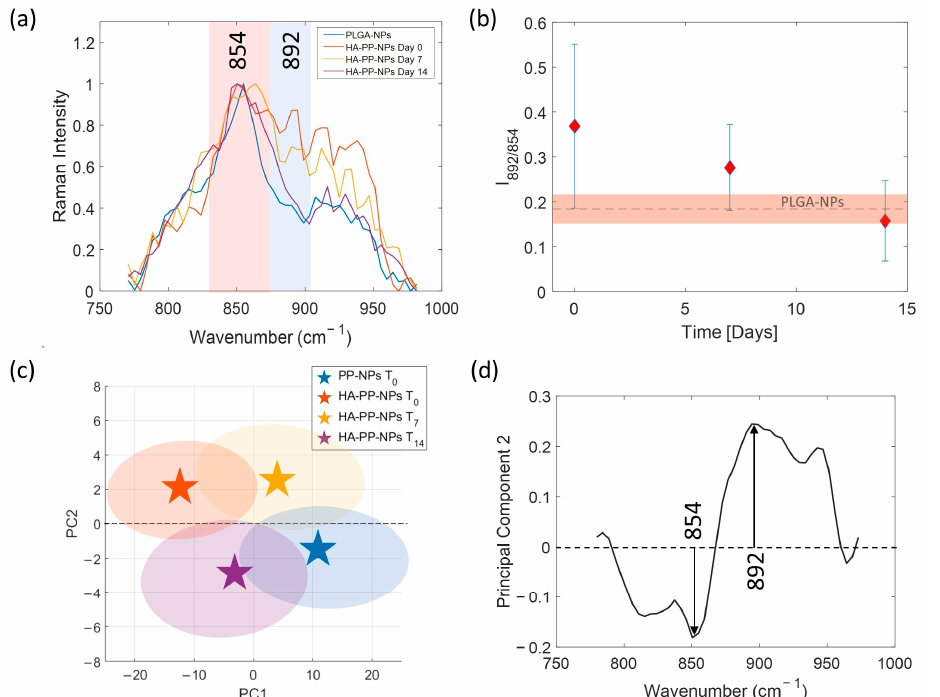
Figure 4. ( a ) Comparison of SERS spectra relative to PP-NPs T 0 and HA-PP-NPs T 0 , T 7 , T 14 ; ( b ) Plot of the ratio intensities I 892/854 as a function of time. The ratio value relative to PP-NP T 0 spectrum is reported as a dashed horizontal line and the corresponding error bar as a red box; ( c ) Score plot of PC1 versus PC2 for PP-NPs T 0 and HA-PP-NPs T 0 , T 7 , T 14 ; ( d ) Loading plot of PC2.